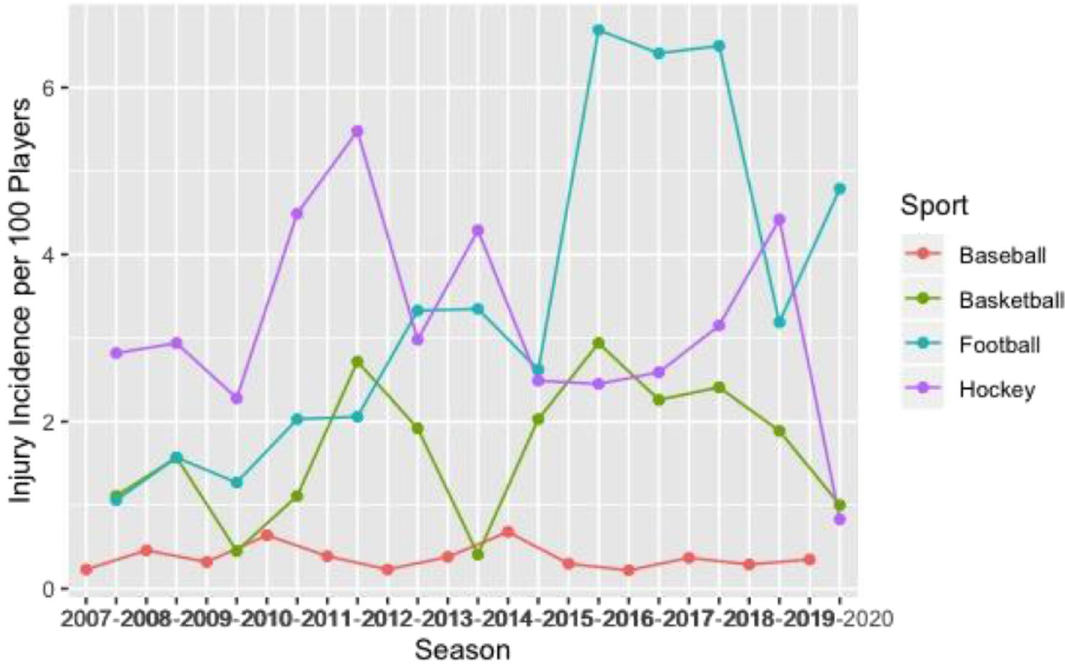
Figure 4. Concussion time-loss injury by sport.